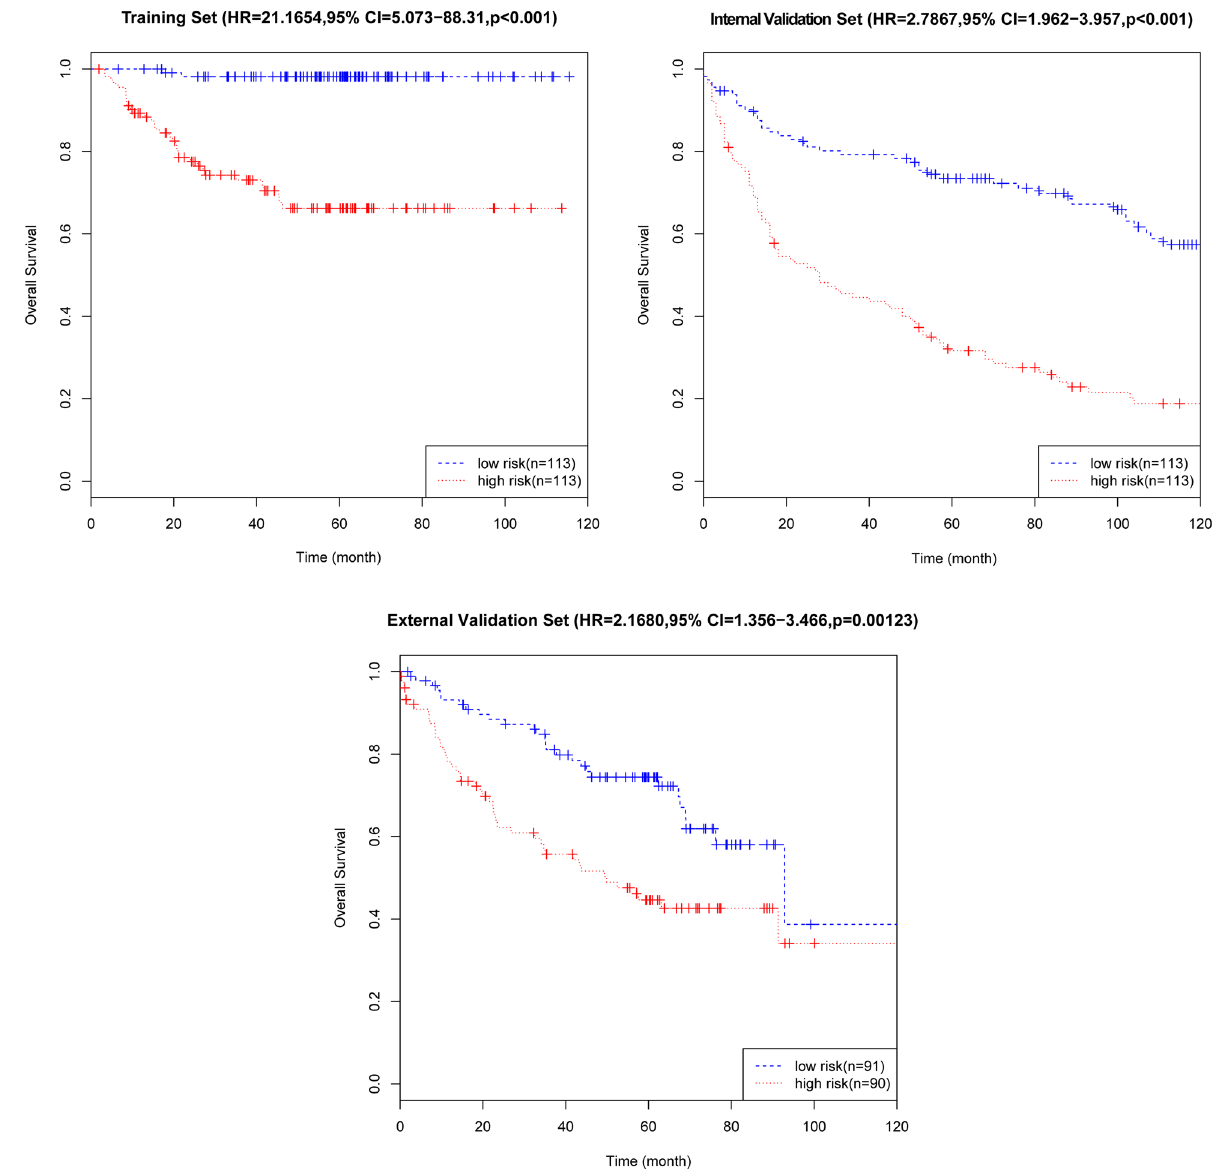
Figure 5. Kaplan–Meier curves of disease-free survival on the basis of the fifteen-mRNA signature in the training, internal validation, and external validation sets. As the result denmonstrated lower scores were associated with longer RFS, and higher scores were associated with shorter RFS in each set ( P < 0.05).